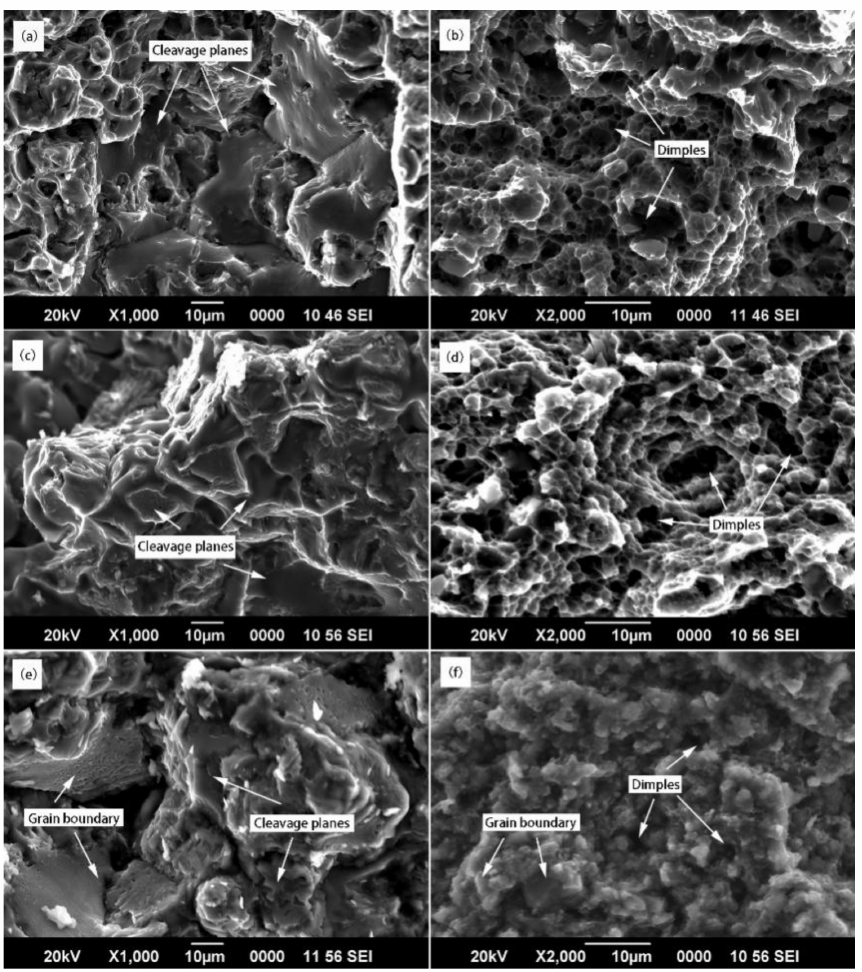
Figure 10. Fracture surfaces of as-cast ( a , c , e ) and as-pressed ( b , d , f ) Al-5.5Mg-xLi-0.1Zr (wt%) alloy with di ff erent Li content: ( a , b ) 1.6 wt%; ( c , d ) 2.0 wt%; ( e , f ) 2.5